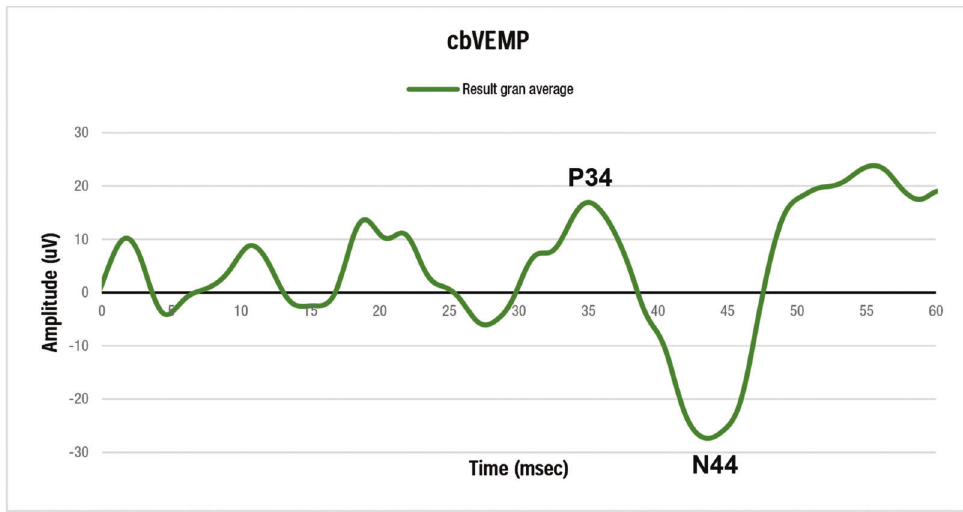
Figure 3 - Grand average resulting from all VEMP examinations captured on the forearm, with emphasis on the P34 positive peak and the N44 negative peak. Table 1 - Latencies, interpeak intervals, and resulting average amplitudes, standard deviations, and normal ranges for VEMP of the forearm. Wave component